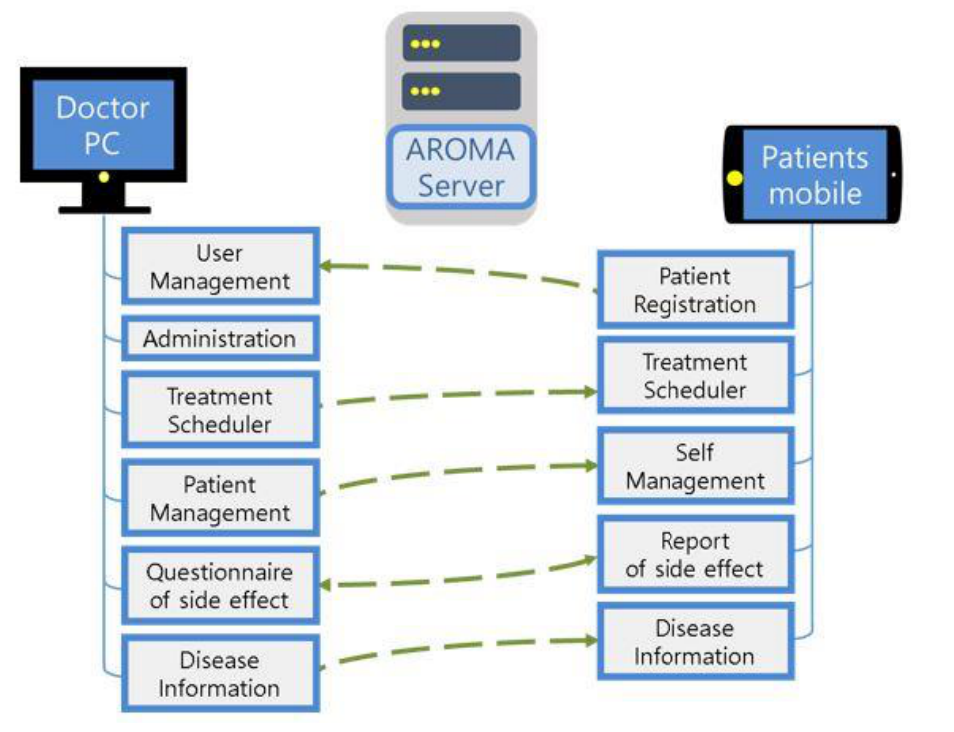
Figure 2. Basic concept of the AROMA system.